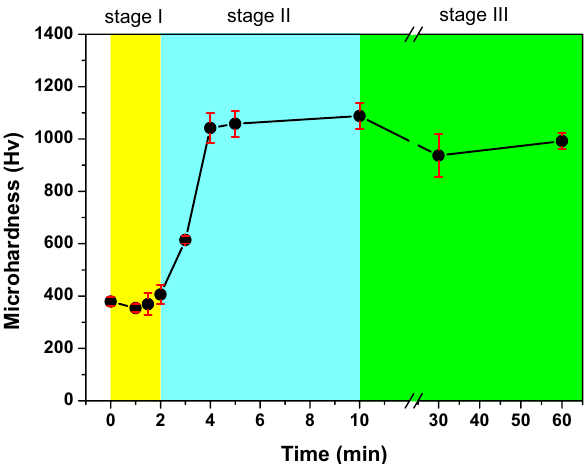
Figure 6. Microhardness of the TiZr alloy specimens as a function of heat treatment time.